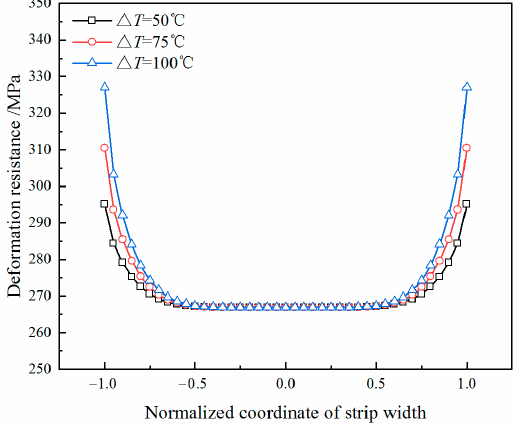
Figure 14. Distribution of the deformation resistance with difference values of Δ T .